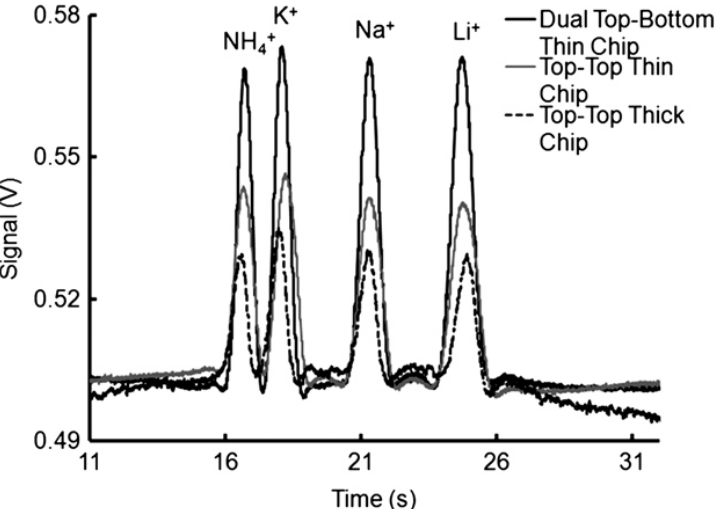
Figure 7. Comparison of the applications of different detector cell designs in CEs of inorganic cations with contactless C 4 D conductivity detection [101]. Electropherograms recorded for 0.5 mM cations (K + , Ca + , Mg + , Li + ) using electrodes in dual top–bottom (black line), top–top (gray line) positions using thin chips, and in the conventional top–top configuration with thick chips (dotted line). CE conditions: channel—85 (65) mm × 50 × 50 μ m, BGE—20 mM MES/His, 2 mM 18-crown-6, pH 6.4, injection at 0.5 kV for 5 s, V: +3 kV. C 4 D detector: a sinusoidal excitation signal of 22 V pp (peak-to- peak) at 300 kHz; electrode distance, 1 mm; electrode width, 1 mm. (Reproduced under permission from John Wiley and Sons. License Number